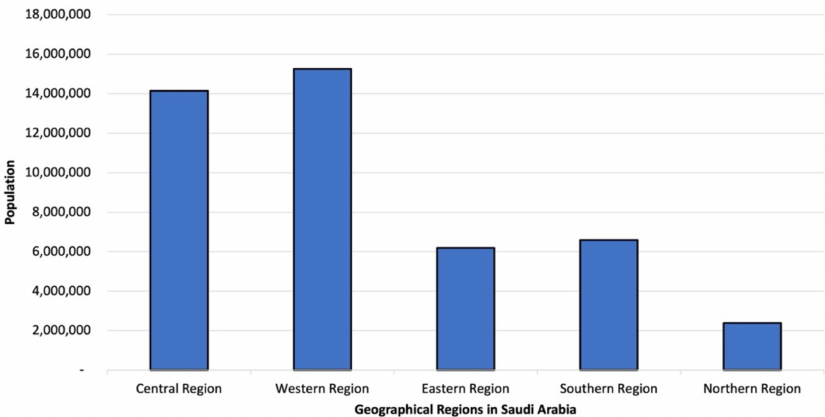
Figure A1. Geographical regions discerption of population growth in 2050 in Saudi